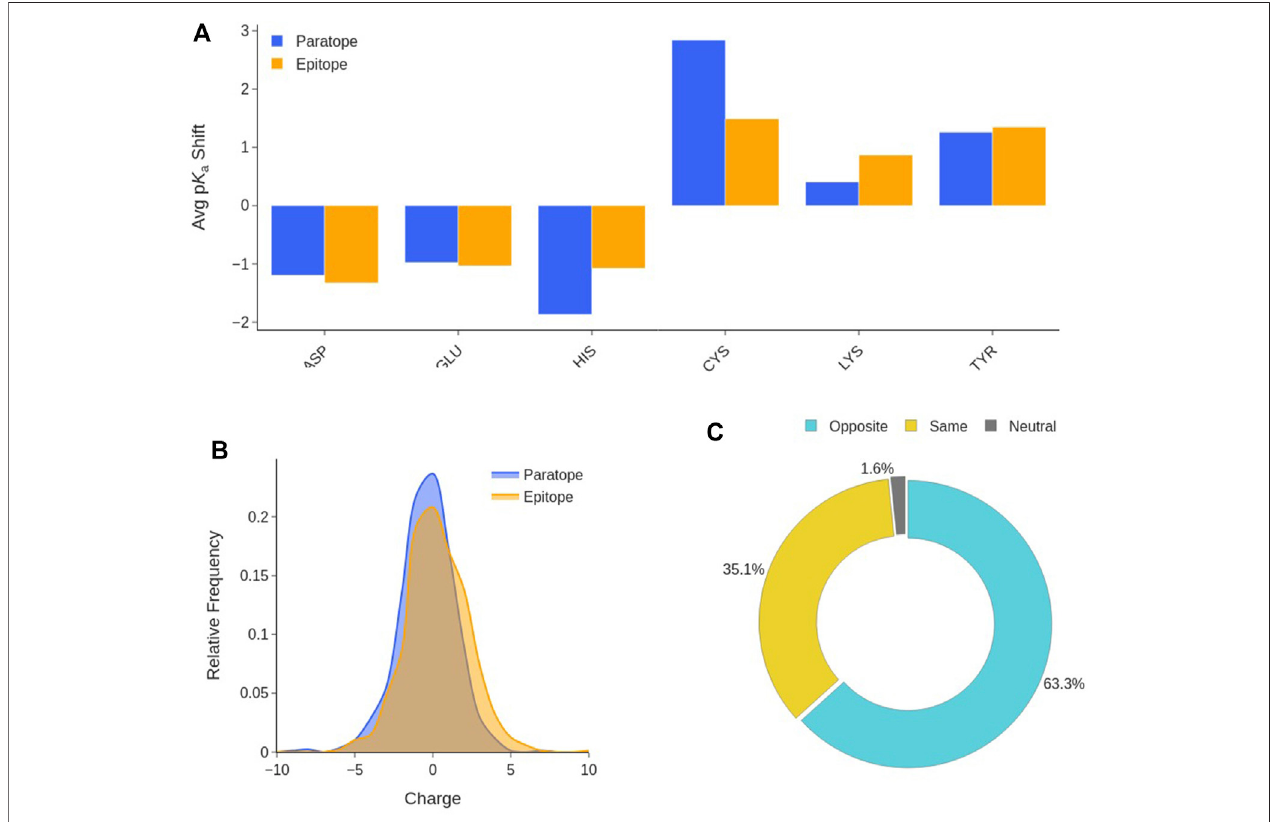
FIGURE 7 | Interface titratable residues characterization. (A) Average p K a shift of titratable residues at the Ab-Ag interface with respect to their value in water. (B) Distributionofthenetchargeintheparatopeand epitopeat pH 7.2. (C) Ab-Ag interface chargecomplementary composition. Distinctions aremade among interfaces in which paratope and epitope have the same charge, opposite charges, and when one partner is